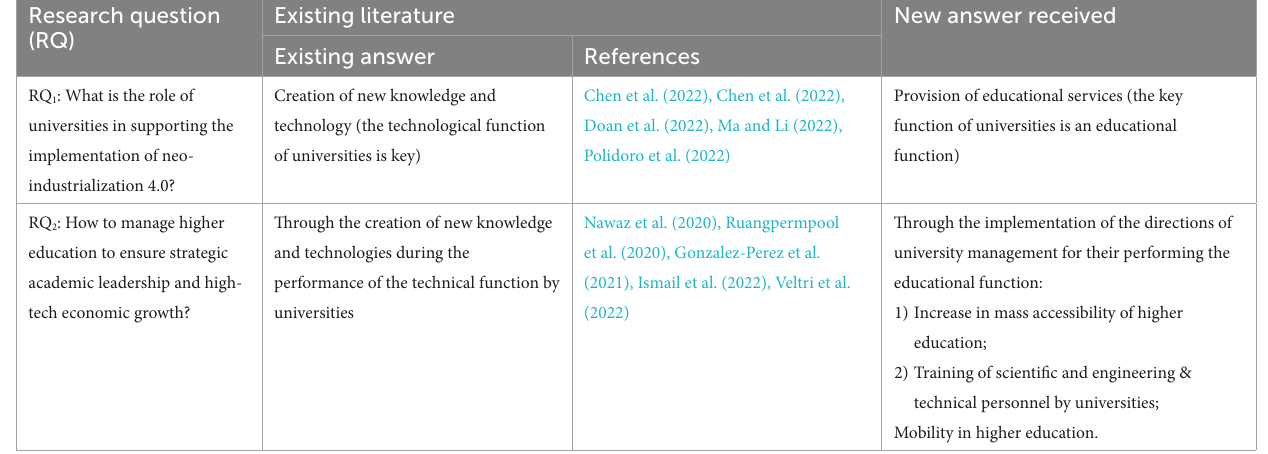
TABLE 3 Comparative analysis of the obtained results with the existing literature in the context of the assigned RQs. Research question